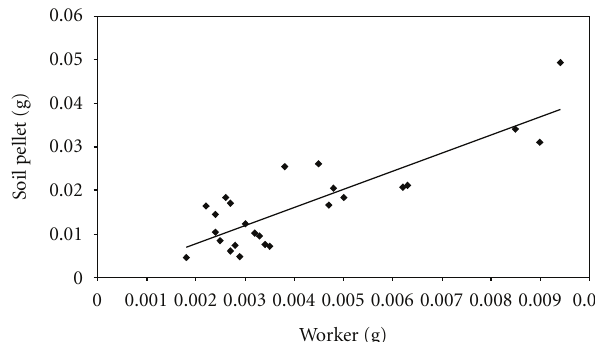
Figure 2: Ratio between mass of workers and their soil load in a natural situation. Linear regression was applied with the “best-fit” linear equation ( x = 0 . 00125 + (0 . 173 ∗ y ), R = 0 . 849, ( t = 7 . 702, d . f . = 24, P < 0 .